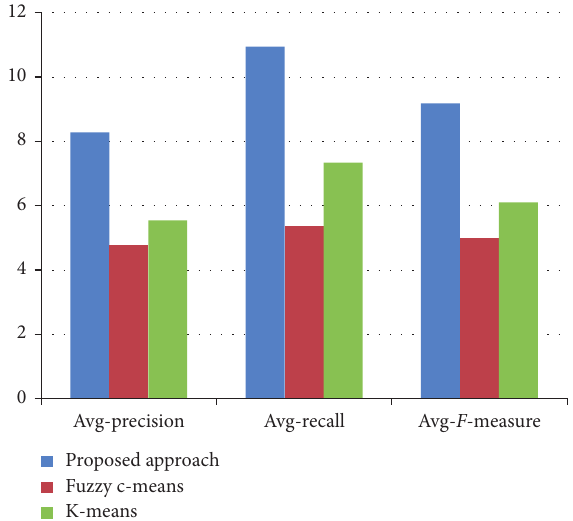
Figure 5: Evaluation of summarization models on different measures using ROUGE - 2 on NYC